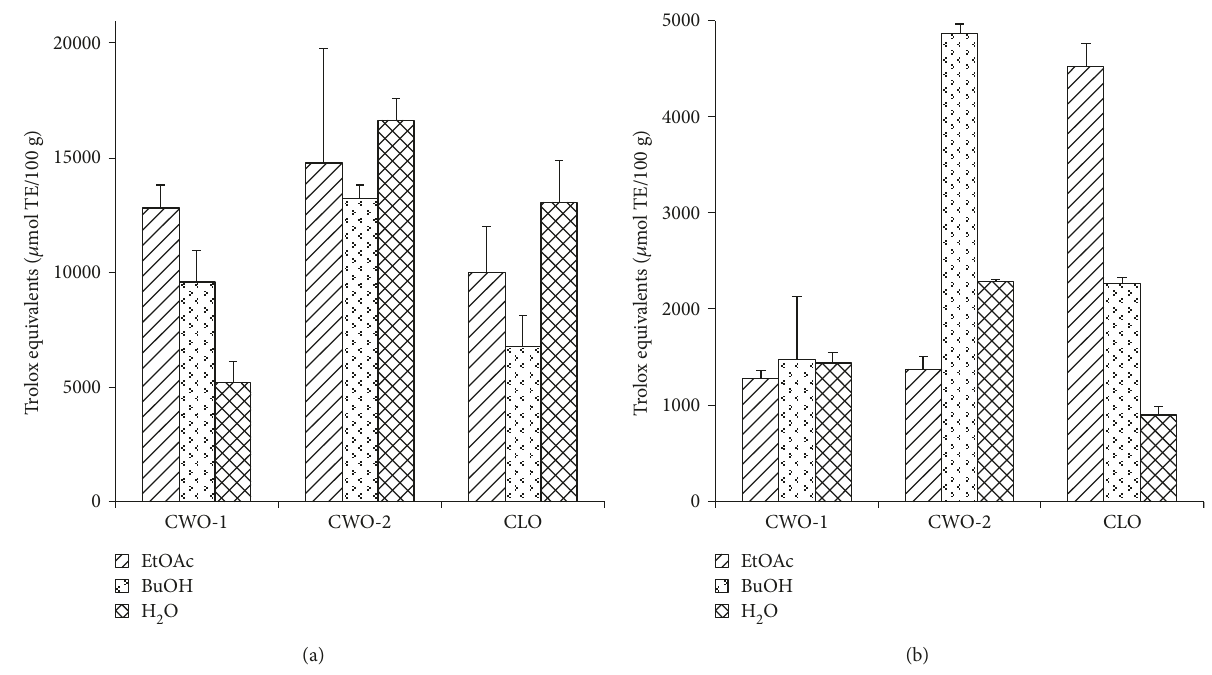
Figure 2: Antioxidative capacity in the extracts. CWO-1, CWO-2, and CLO which were sequentially extracted using EtOAc, BuOH, and water. The results are shown as Trolox equivalents ( μ mol TE/100 g). (a) ORAC assay with extract concentrations of 0.1mg/ml. (b) FRAP assay with extract concentrations of 10 mg/ml. CWO=cold-pressed whale oil; CLO=cod liver oil; EtOAc=ethyl acetate; BuOH =butyl alcohol; ORAC =oxygen radical absorbance capacity; FRAP =ferric reducing antioxidant